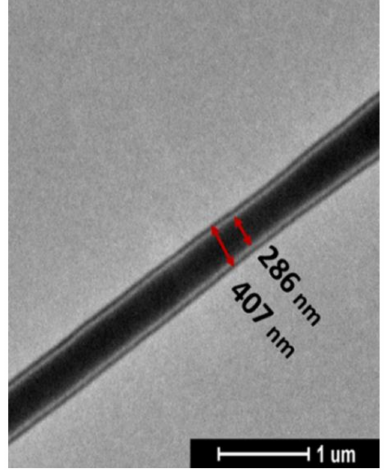
Figure 2. TEM images of PCL-Cur/PLA fiber.